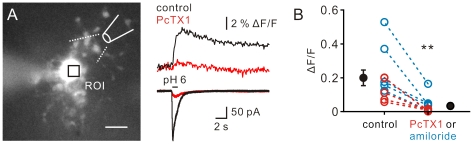
Activation of ASIC1a channels results in [Ca2+]i elevation.(A) Fluorescence image of an NG2 cell loaded with OGB-1. Square, the region of interest (ROI). Scale bar, 10 µm. Traces, an example of focal acid puffing to an NG2 cell induced changes of fluorescence signals (top) at the ROI in the control (black) and in the presence of PcTX1 (red) and their corresponding inward currents (bottom). (B) Summary of the change of peak amplitude of [Ca2+]i in the control and in the presence of PcTX1 or amiloride. **P<0.005.